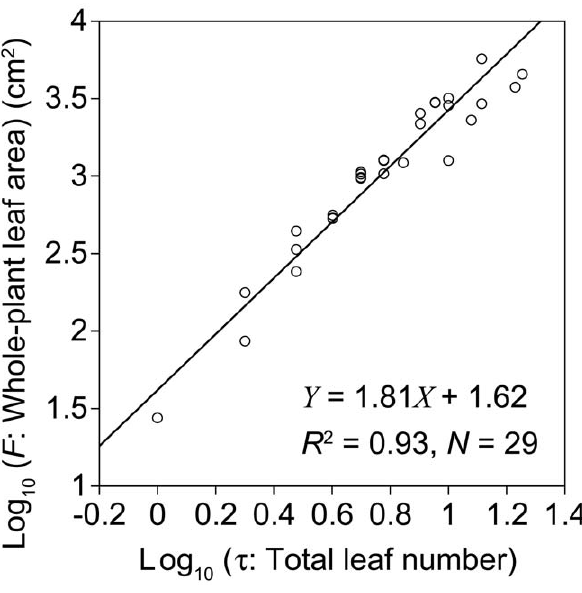
Figure 4. Log-log relationship between whole-plant leaf area and total leaf number. Each open circle represents one individual plant. The solid line shows the standardized major axis regression ( r 2 =0.93, n =29).